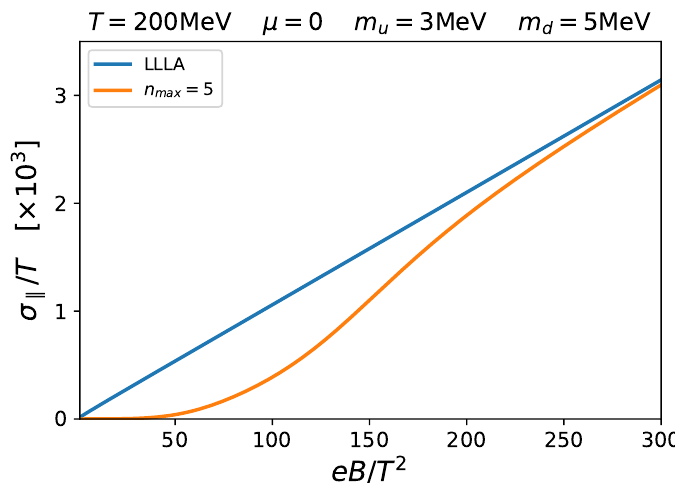
Figure 8 . Magnetic (cid:12)eld dependence of the longitudinal electric conductivity up to an asymp- totically strong (cid:12)eld region. The full results (orange color) slowly approaches the results from the LLLA (blue